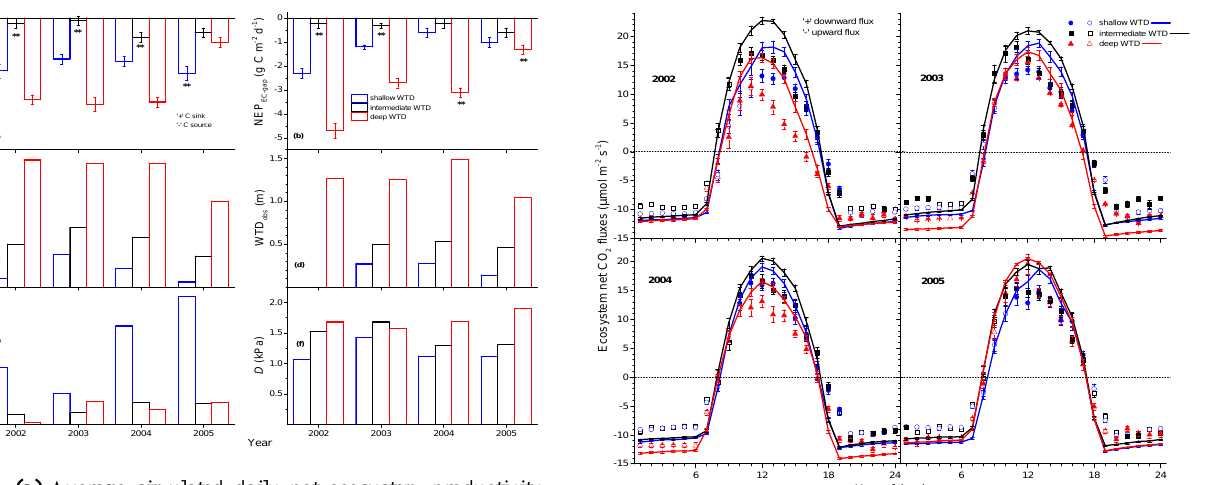
Fig. 6. (a) Average simulated daily net ecosystem productivity (NEP sim ) (b) average EC-gap filled daily net ecosystem pro- ductivity (NEP EC − gap ) (c) average simulated water table depths (WTD sim ) (d) average observed water table depths (WTD obs ) (e) total observed precipitation ( P) , and (f) average mid-day (10:00– 14:00LT) vapour pressure deficit ( D) during shallow (DOY 1–30, tively), intermediate (DOY 121–150, 146-1-75, 181–210 and 121– 150 in 2002, 2003, 2004 and 2005 respectively) and deep (DOY 2005 respectively) water table depth (WTD) hydroperiods (delin- eated by vertical dotted lines in Figs. 2–5) over a drainage affected tropical peat swamp forest at Palangkaraya, Indonesia. Bars repre- sent standard errors of means. Asterisks (**) at the top of a col- umn represent significant ( P <0.01) difference from the adjacent column(s).